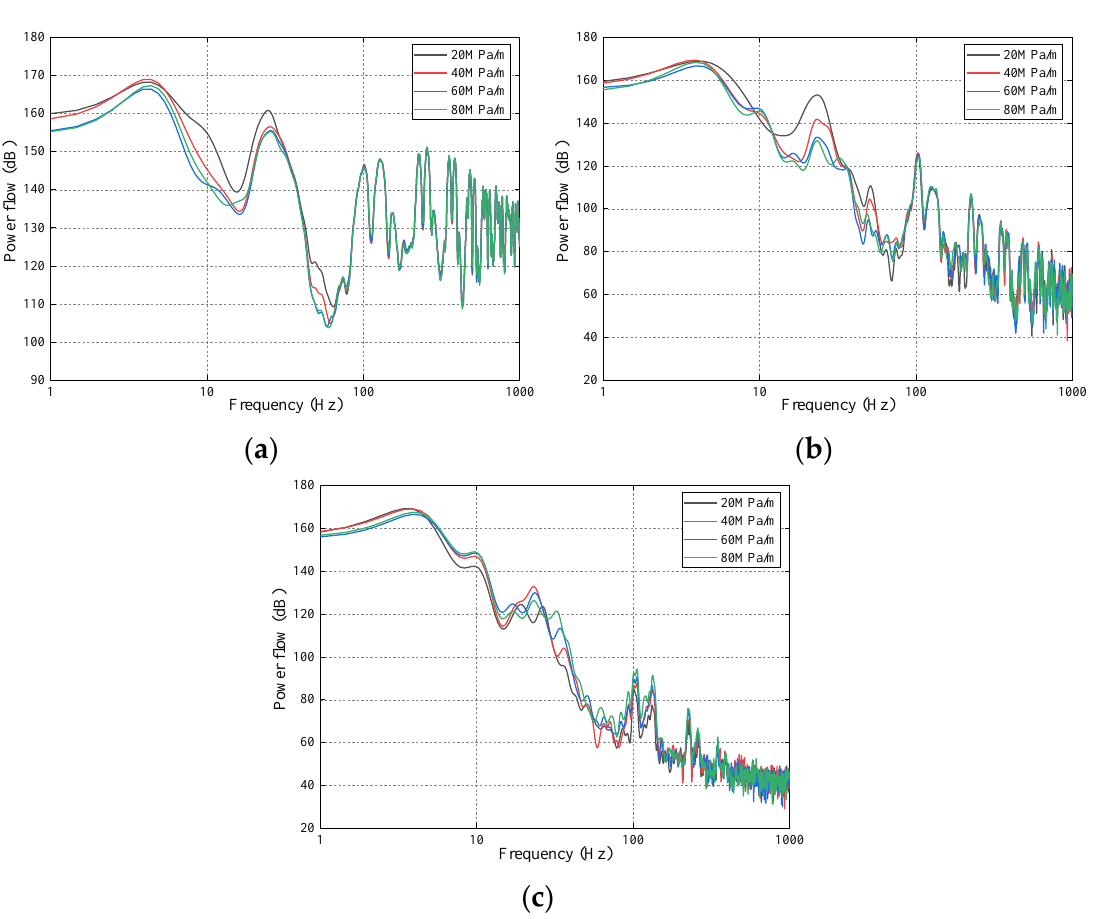
Figure 7. The power flows of ( a ) the rail, ( b ) the slab track, and ( c ) the bridge. Figure 9. The power flows of ( a ) the rail, ( b ) the slab track, and ( c ) the